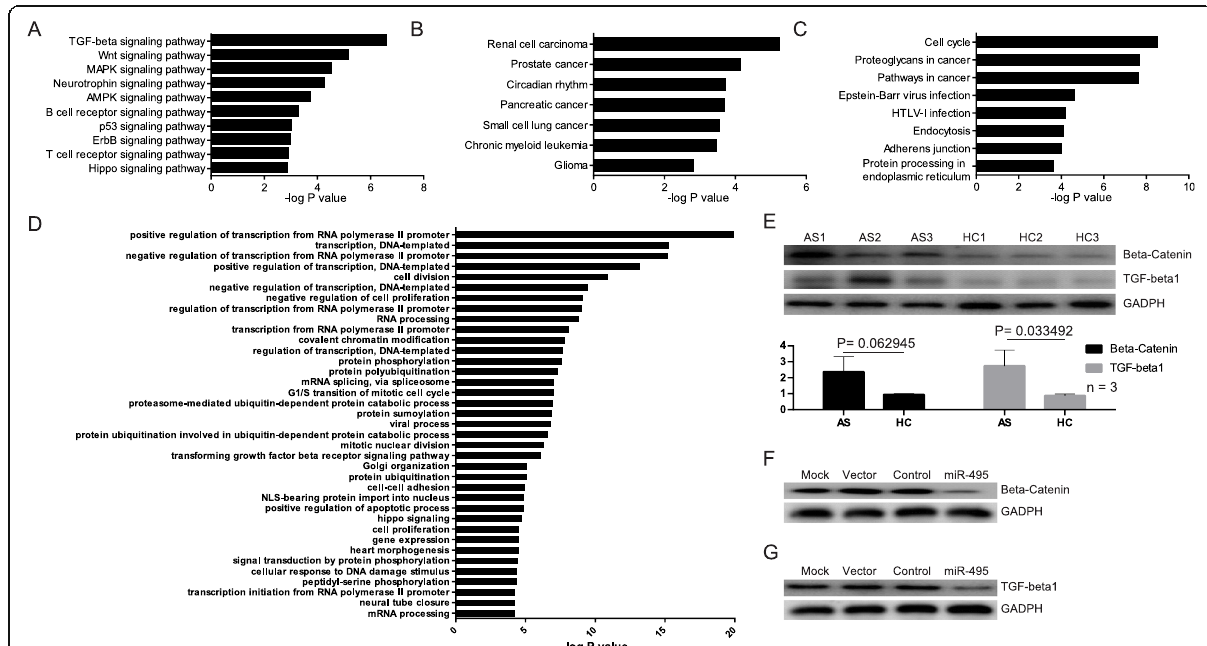
Fig. 6 Exploring the potential role of miR-495 . a Classical signaling pathway analysis. b Signaling pathways related to disease analysis. c Other signaling pathway analysis. Signaling pathways were analyzed by KEGG with a P value threshold of 0.01. d GO categories of miR-495 . The -log P value came from enrichment analysis. The 39 GO categories (biological processes) were all with a P value threshold of 0.01. e Western blot of β - catenin and TGF- β 1. AS1, AS2, and AS3: different patients with AS. Healthy controls were indicated as HC1, HC2, and HC3. n = 3: repeated samples in each group. P values were indicated as shown. F Western blot of β -catenin in transfected primary PBMCs. Mock: untreated group. Vector: blank vector group. Control: mutated miR-495 over-expression group. MiR-495: miR-495 over-expression group. g Western blot of TGF- β 1 in transfected primary PBMCs. Mock: untreated group. Vector: blank vector group. Control: mutated miR-495 over-expression group. MiR-495: miR-495 over-expression Supplementary information Supplementary information accompanies this paper at https://doi.org/10. 1186/s10020-020-00157-3. Additional file 1: Figure S1. Dual luciferase assays in Jurkat cells. Mock: untreated group. MiR-495 PDCD10 indicated wild-type miR-495 and